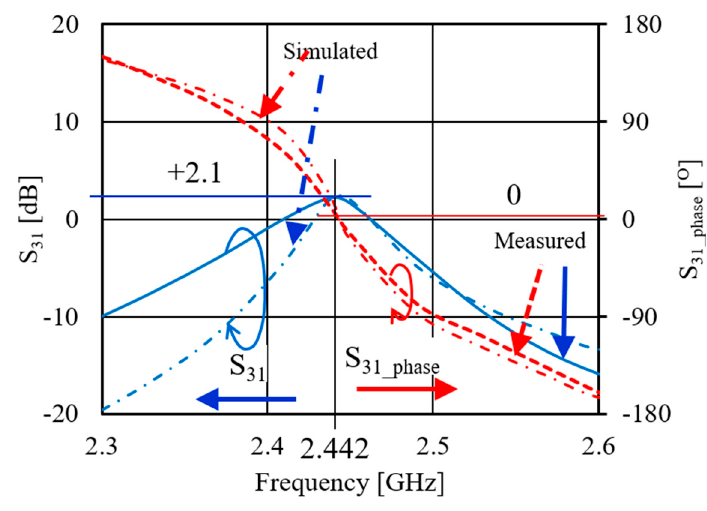
Figure 11. Measured magnitude and phase of the S 31 of Figure 5.